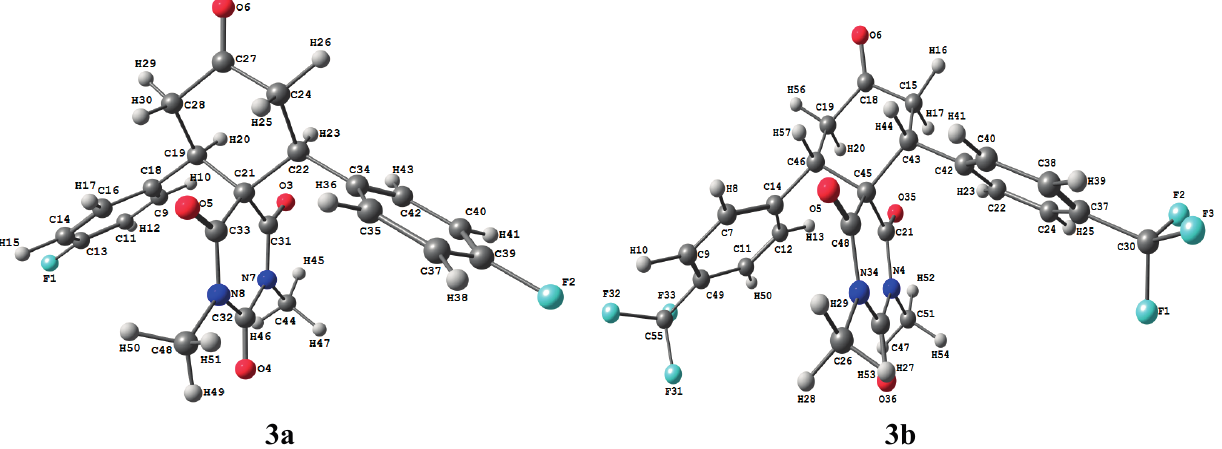
Figure 5. The optimized molecular structure of the studied compounds 3a , b